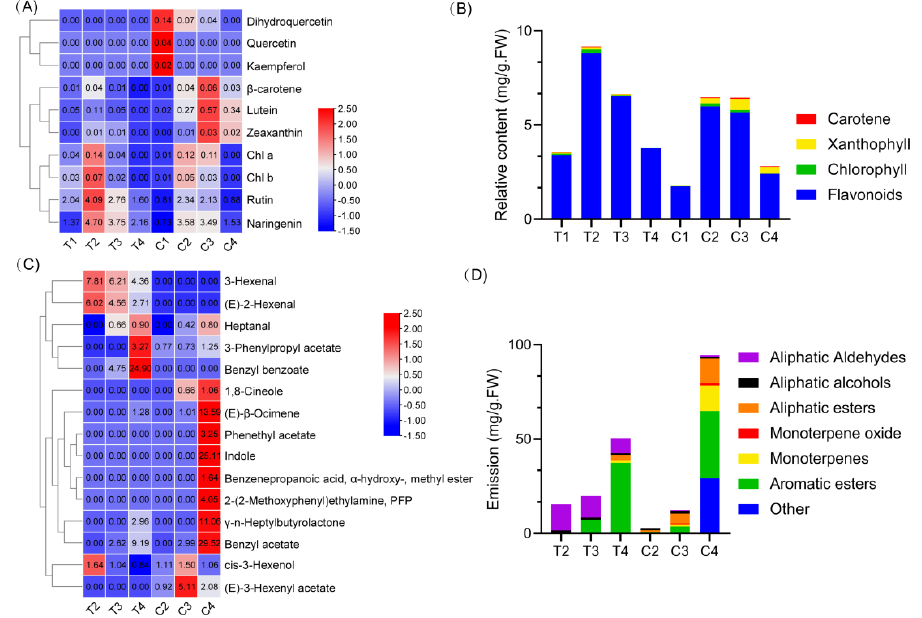
Figure 2. Comparison of the changing profiles of floral pigment and fragrant component in tepals and coronas. A . The heatmap shows the amount of pigments in tepals and coronas during flower development. B . Changing profiles of pigments in tepals and coronas; C . The heatmap shows volatile organic components (VOCs) amounts in tepals and coronas during flower development; D . Changing the profiles of volatiles in tepals and coronas. The heatmap was drawn by TBtools software and the function “scale” was used for normalized the data by rows.